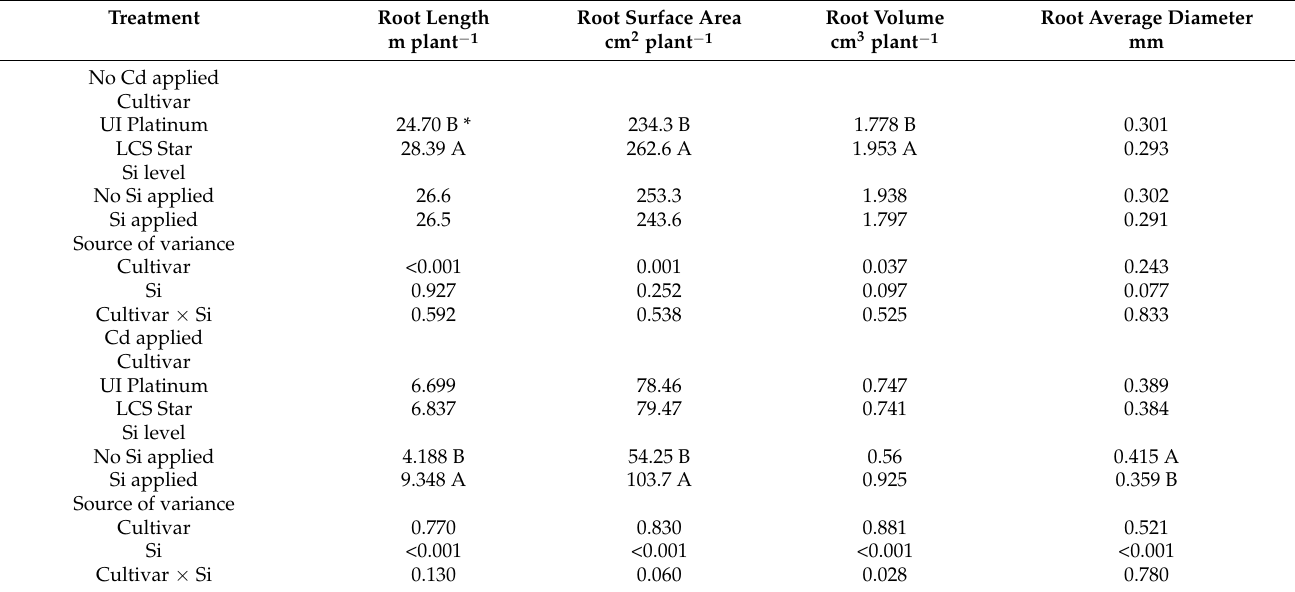
Table 1. Root morphological characteristics affected by cultivar and Si level without and with Cd